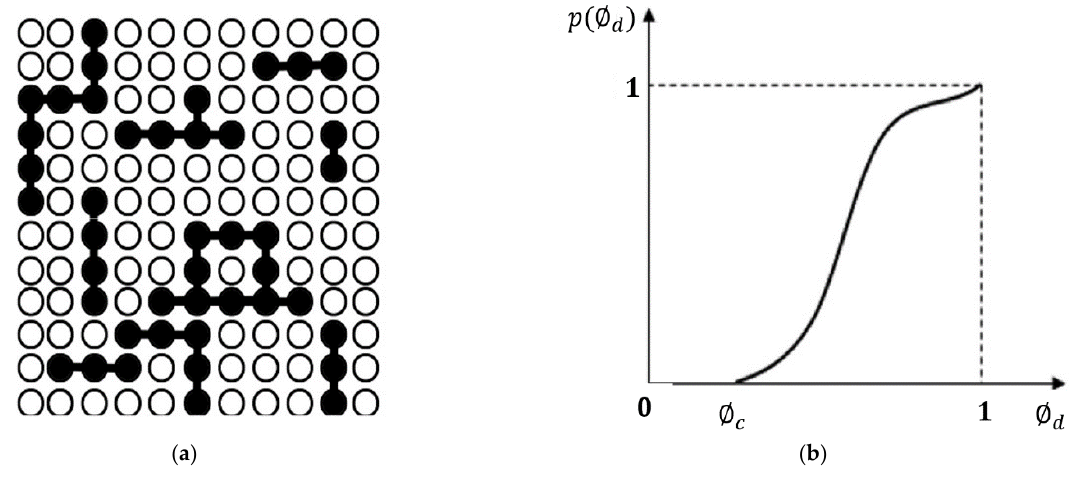
Figure 7. Schematic diagram of site percolation ( a ) and probability of percolation ( b ) [32].